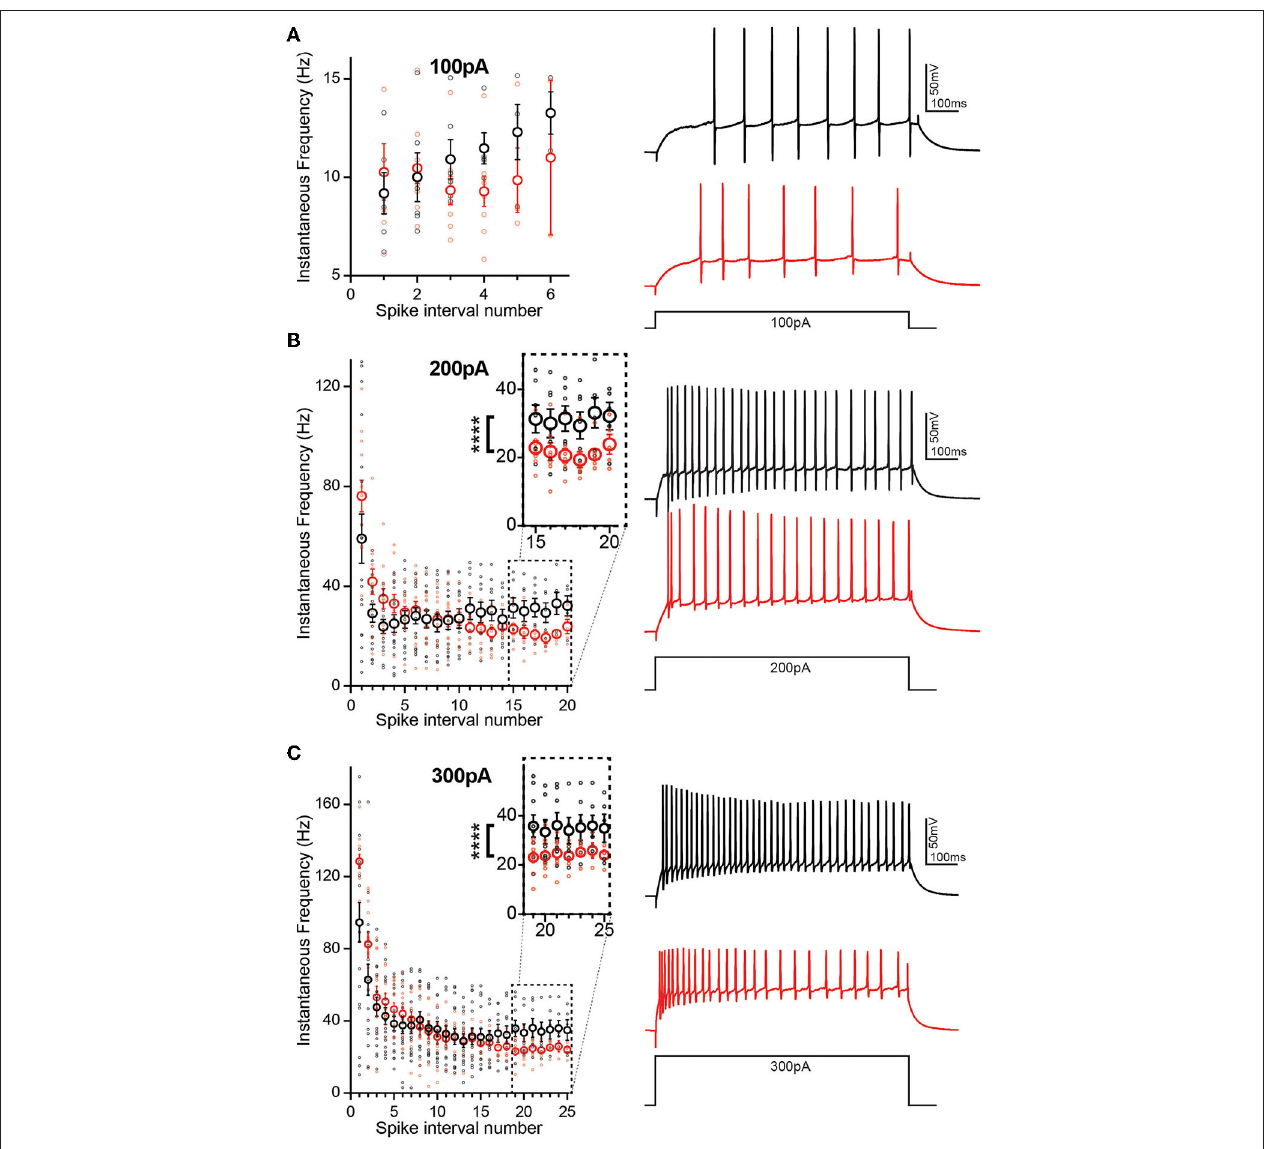
FIGURE 5 | Initial spike frequency and spike accommodation are greater in TgF344-AD DGCs. (A) (left) Graph of instantaneous firing frequency (Hz) between action potentials (spike intervals) at 100pA to include TgF344-AD (red) and Wt (black) DGCs that successfully fired an action potential at + 100pA current injection. (Right) example traces. (B) (Left) graph of instantaneous firing frequency (Hz) between action potentials (spike intervals) at 200pA showing both increased initial spike frequency and greater accommodation (inset) ( p < 0.0001). (Right) example traces. (Wt, n = 7 cells/5 animals; Tg, n = 5 cells/5 animals) (C) (left) Graph of instantaneous firing frequency (Hz) between action potentials (spike intervals) at 300pA showing both increased initial spike frequency and greater accommodation (inset) ( p < 0.0001). (Right) example traces. (**** p < 0.0001 Wt, n = 7 cells/5 animals; Tg, n = 7 cells/5 animals). Data represent mean ± SEM. Significance is determined using the unpaired t -test with Welch’s